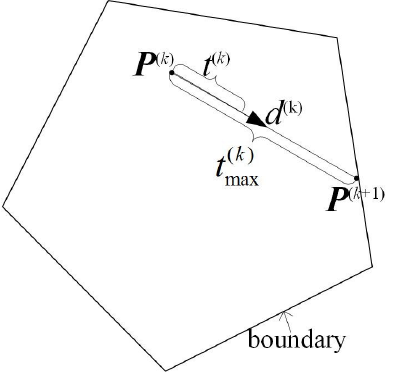
Figure 1. Maximum step length and small step